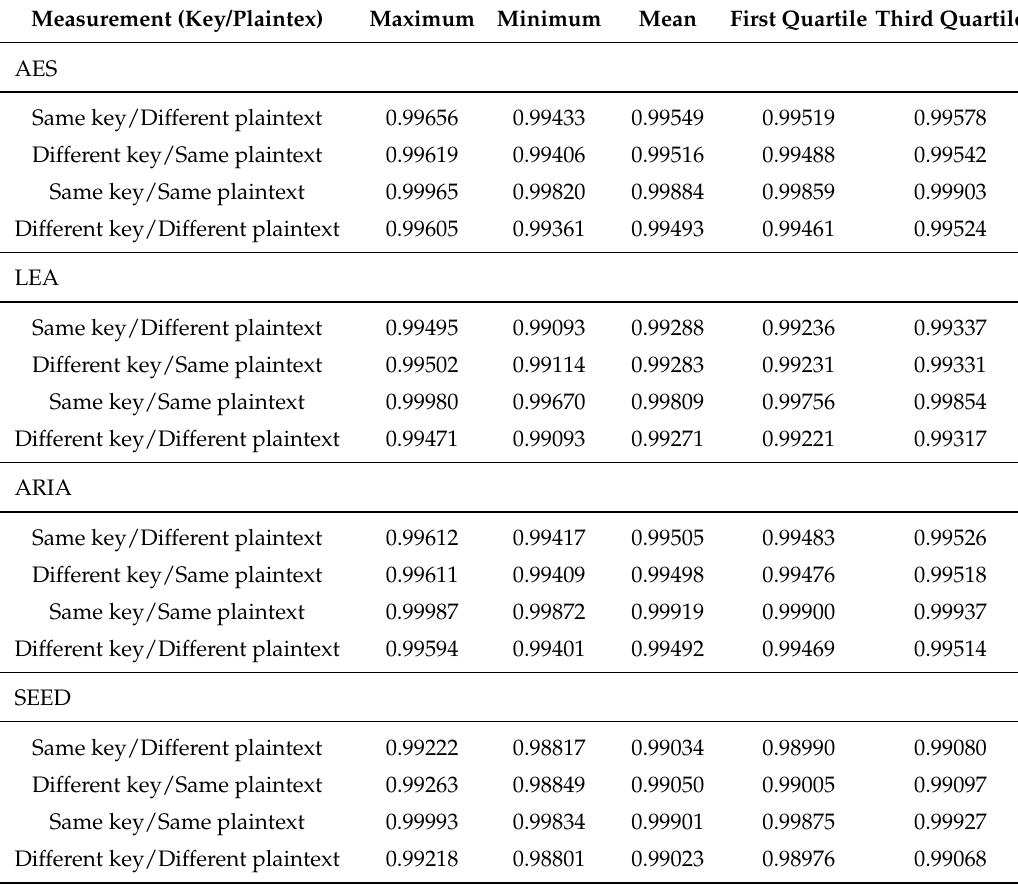
Table 1. Correlation coefficient between power consumption traces with different block ciphers.